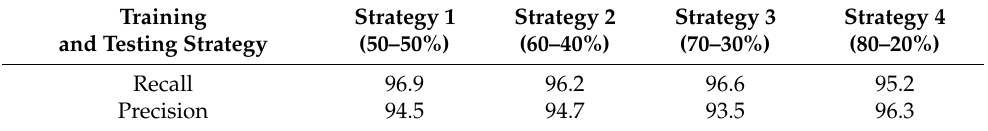
Table 15. Value for Recall and Precision at 4 different training and testing strategies for dataset 2